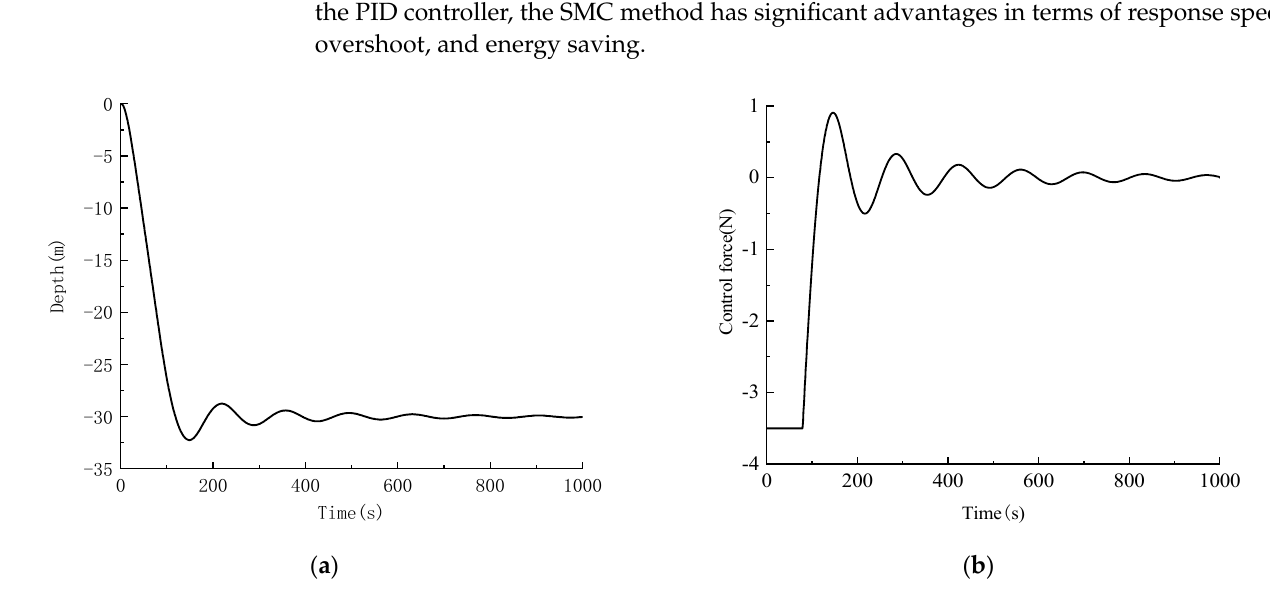
Figure 3. Simulation curves of the sliding mode control. ( a ) Depth curves at different external forces. ( b ) Control force curves at different external forces. ( c ) Speed curves at different external forces. ( d ) Trajectory − tracking phase diagram at different external forces. ( e ) Trajectory − tracking phase dia- gram at different mass. ( f ) Phase diagram at different damping coefficients The simulation curve of the conventional PID depth controller is shown in Figure 4.